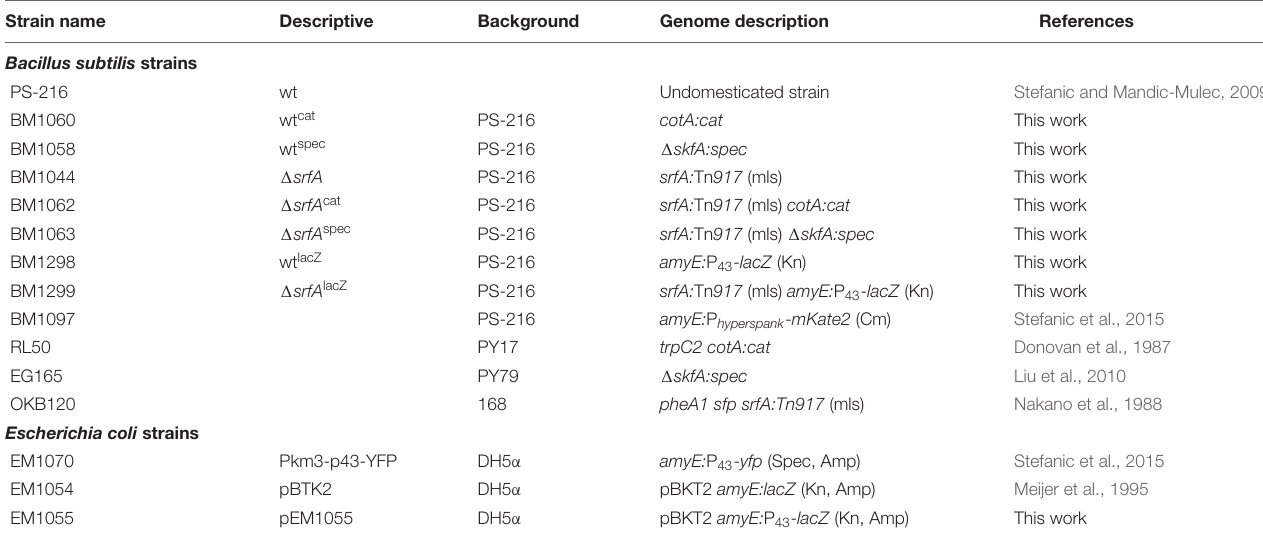
TABLE 1 | Strains used in this study.